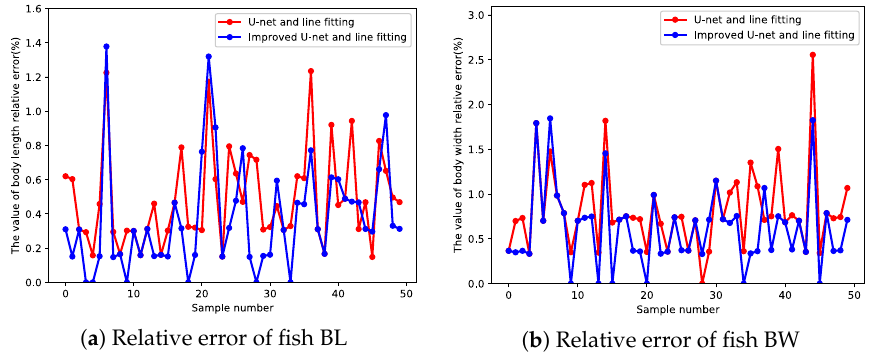
Figure 20. Comparison of relative measurement errors using two networks combined with line